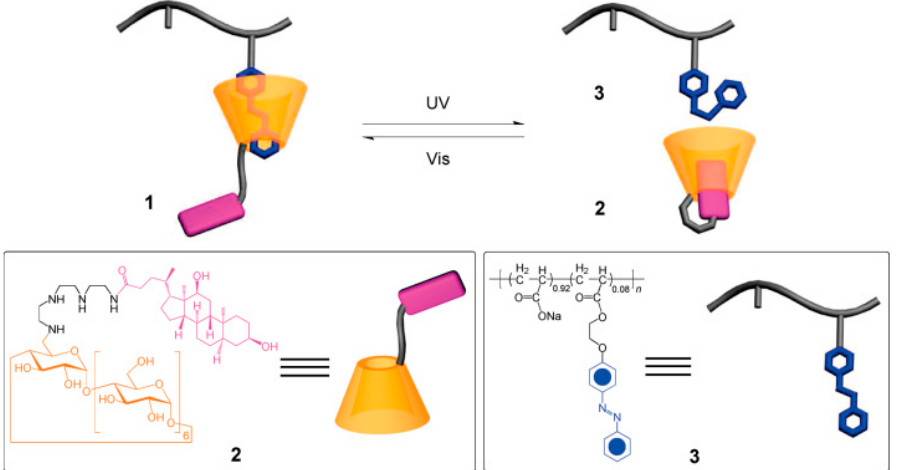
Figure 1. Supramolecular inclusion complex 1 formed from deoxycholate- β -CD derivative 2 and azobenzene-branched poly(acrylic acid) copolymer 3 . Reprinted from [34] with permission from the American Chemical Society (2009).